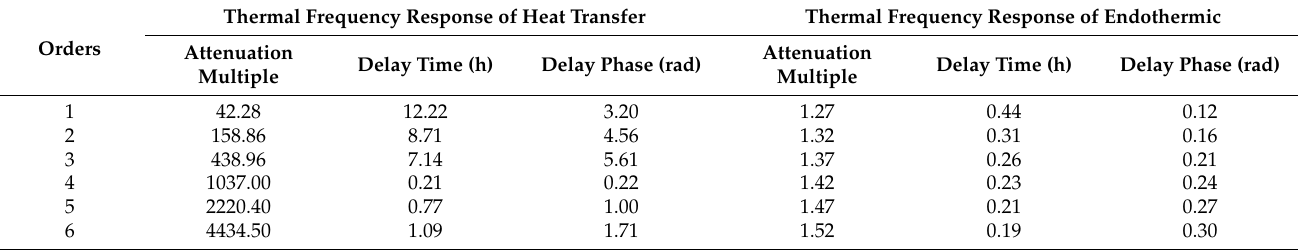
Table 5. Thermal frequency response of the external wall of selected underground